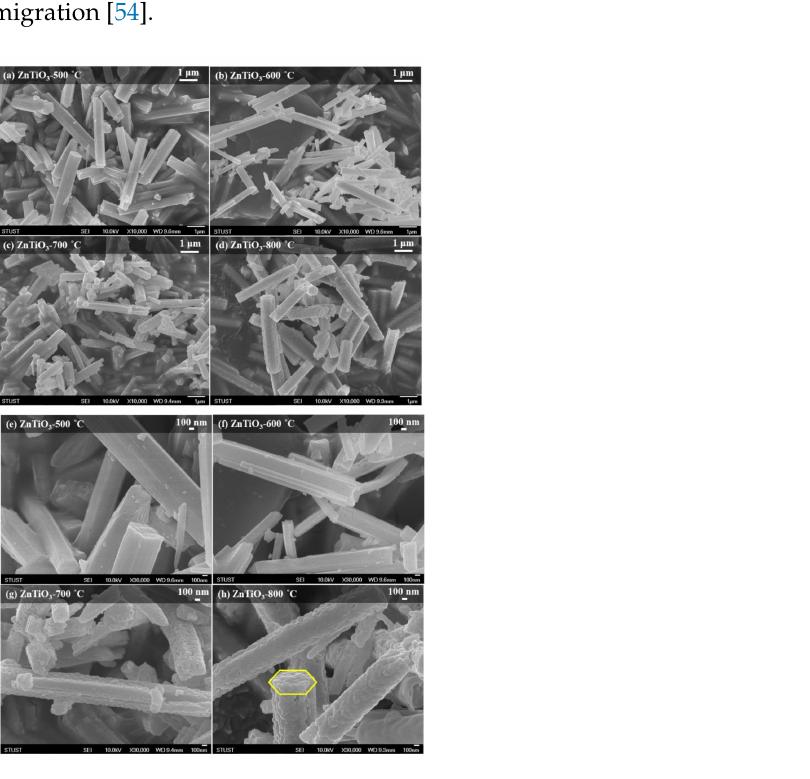
Figure 4. ( a – d ) SEM images of ZnTiO 3 -500 ◦ C, ZnTiO 3 -600 ◦ C, ZnTiO 3 -700 ◦ C, and ZnTiO 3 -800 ◦ C at a magnification of 10,000 × . ( e – h ) SEM images of ZnTiO 3 -500 ◦ C, ZnTiO 3 -600 ◦ C, ZnTiO 3 -700 ◦ C, and ZnTiO 3 -800 ◦ C at a magnification of 30,000 ×